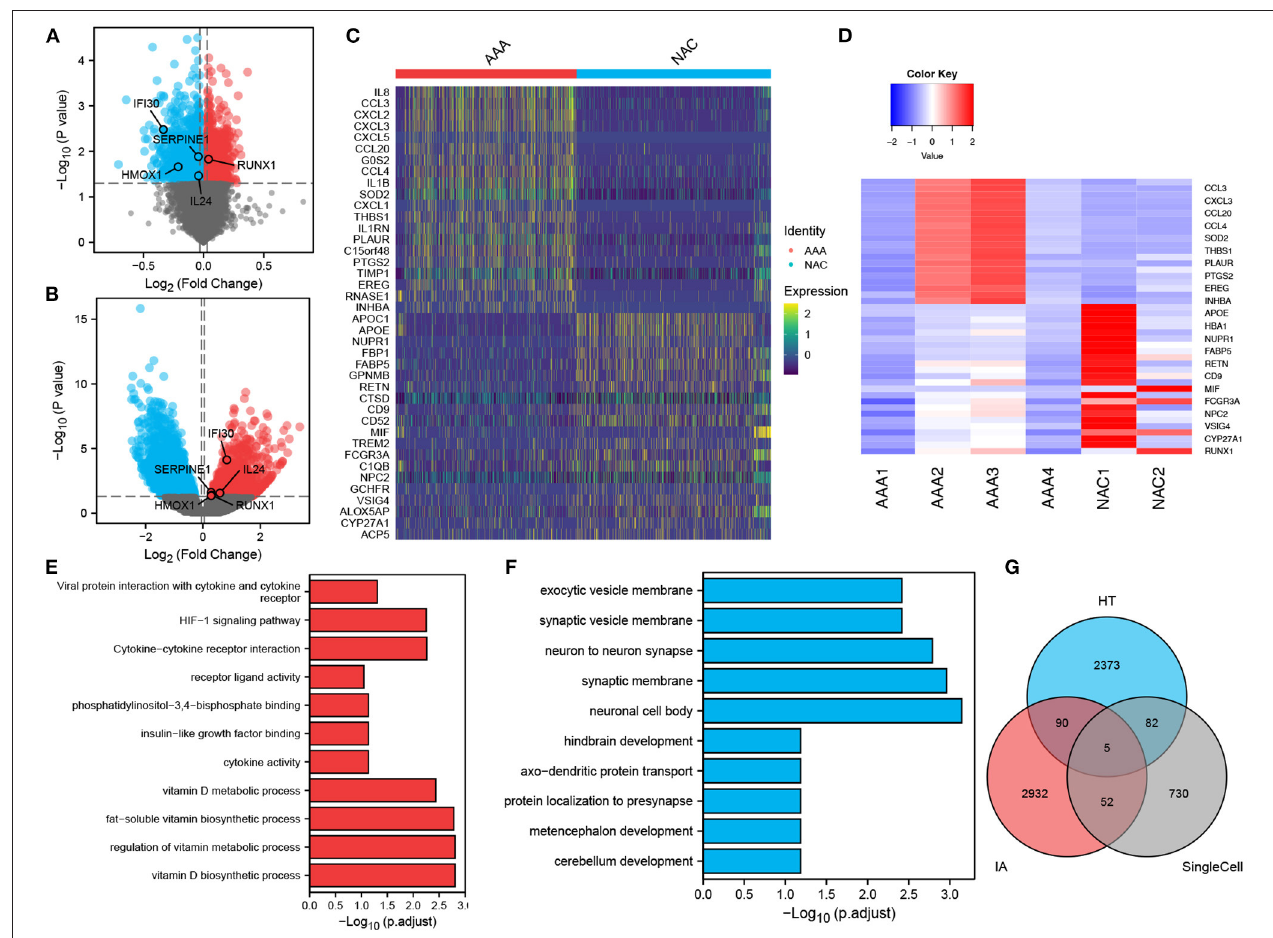
FIGURE 4 | Differentially expressed genes and intersection analysis. (A,B) Volcano plots showing the results of tests for differentially expressed genes in (A) HT, and (B) IA, respectively, and the differences in expression of GOIs are marked in the plots. (C,D) . Differentially expressed genes in monocytes/macrophages obtained by applying (C) FindMarker, or (D) DEGs. (E,F) Differential gene-enriched (E) up-regulation pathway and (F) down-regulation pathway shared in HT and IA. (G) Intersection analysis of HT-associated DEGs, IA-associated DEGs and monocytes/macrophages-associated DEGs revealed five GOIs.